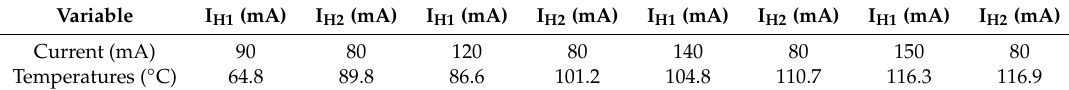
Table 3. Experimentally measured maximum temperatures on the heaters H 1 and H 2.